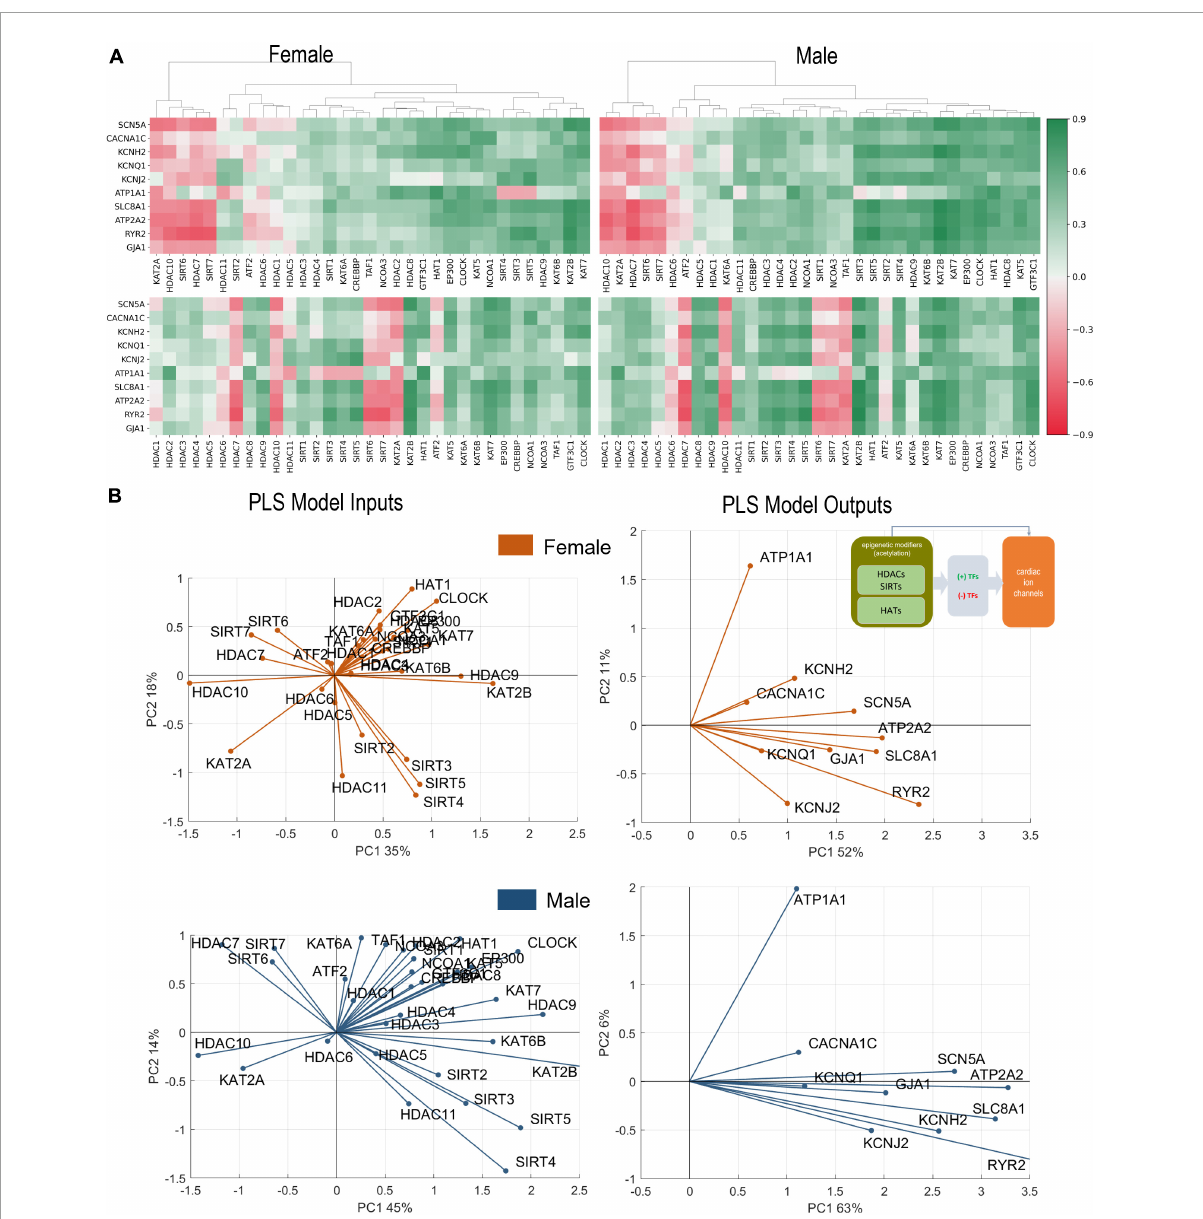
FIGURE2 Analysis of links between acetylation modifiers (HDACs, SIRTs, and HATs) and key cardiac ion channels based on transcription. (A) Pearson’s correlation of ion channels with HDACs, SIRTs, and HATs for female (left) and male (right) LV heart samples. Positive/negative correlations are coded in green/red and shaded by their strength. The top correlation matrices are grouped using agglomerative clustering which generates the linkages. The unorganized correlation coefficients are on the bottom (B) . PLS regression models for female (orange) and male (blue) samples. Inset in (B) shows the models being investigated. The results are presented in biplots for the PLS model inputs (left) and model outputs (right). The biplots are projections of the model parameters onto the space of the first two latent variables of the constructed 4-latent-variable PLS models; shown are also the % variance explained for each latent variable. All biplots represent the average results from 1,000 Monte Carlo PLS runs with random selection of training and testing samples (with the testing samples representing 10%). Proximity in angle between the lines for the model variables indicates co-regulation/similarity of action; the size of the lines signifies the importance of the variable in the shown projection. For example, ATP2A2 is strongly influenced by the histone modifiers and is mainly represented in component 1 in the male and the female models (right panels). Positive co-regulation by SIRT 3, 4, and 5 and negative co-regulation of SIRT 6 and 7 on cardiac ion channels are strong in both the female and male models (left panels) (see text for more